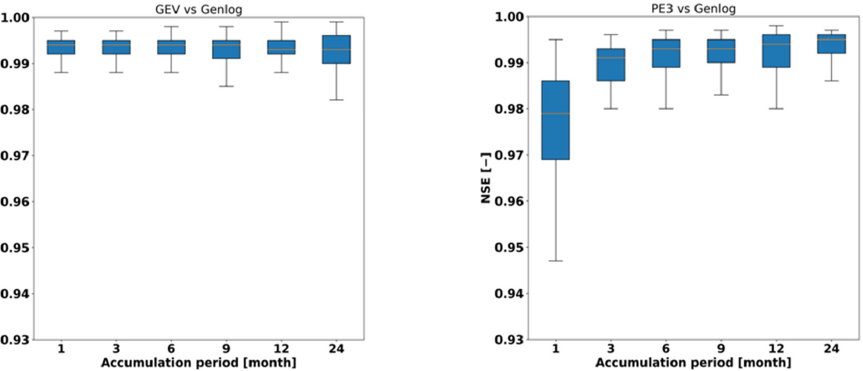
Figure 4. Boxplots of the NSE values (see Equation (6)) of 125 gauging station SPEI values at different accumulation periods when the GEV and the PE3 distribution are compared relative to the Genlog distribution (left and right,